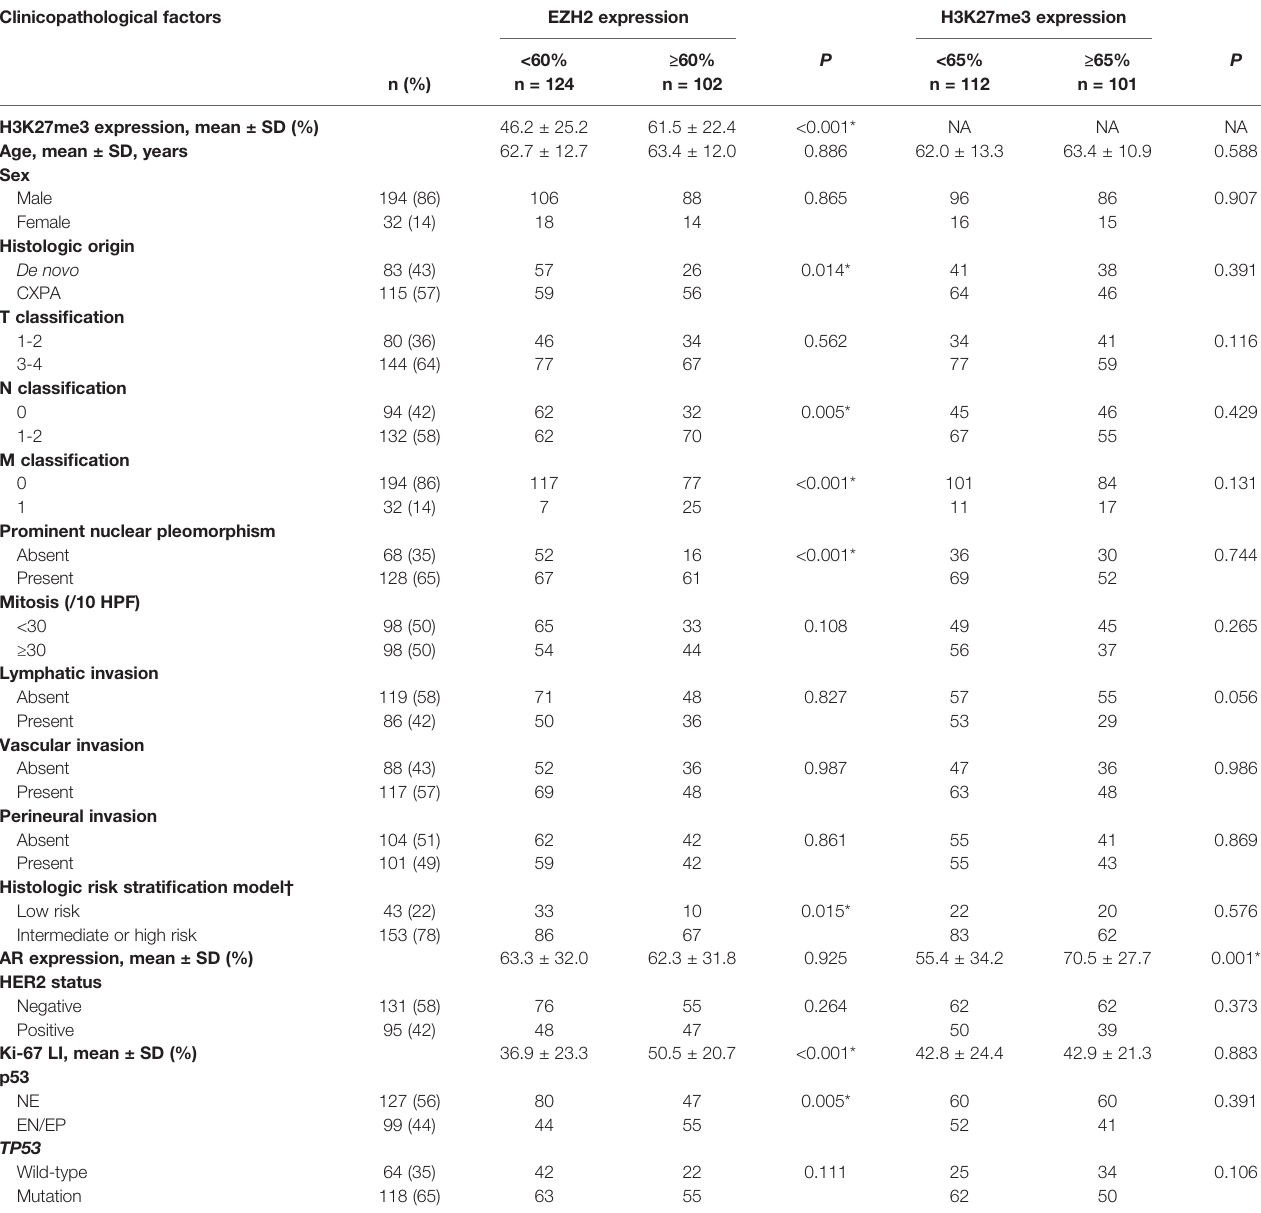
TABLE 2 | Patient characteristics and the correlation between the EZH2/H3K27me3 expression and clinicopathological factors. Clinicopathological factors EZH2